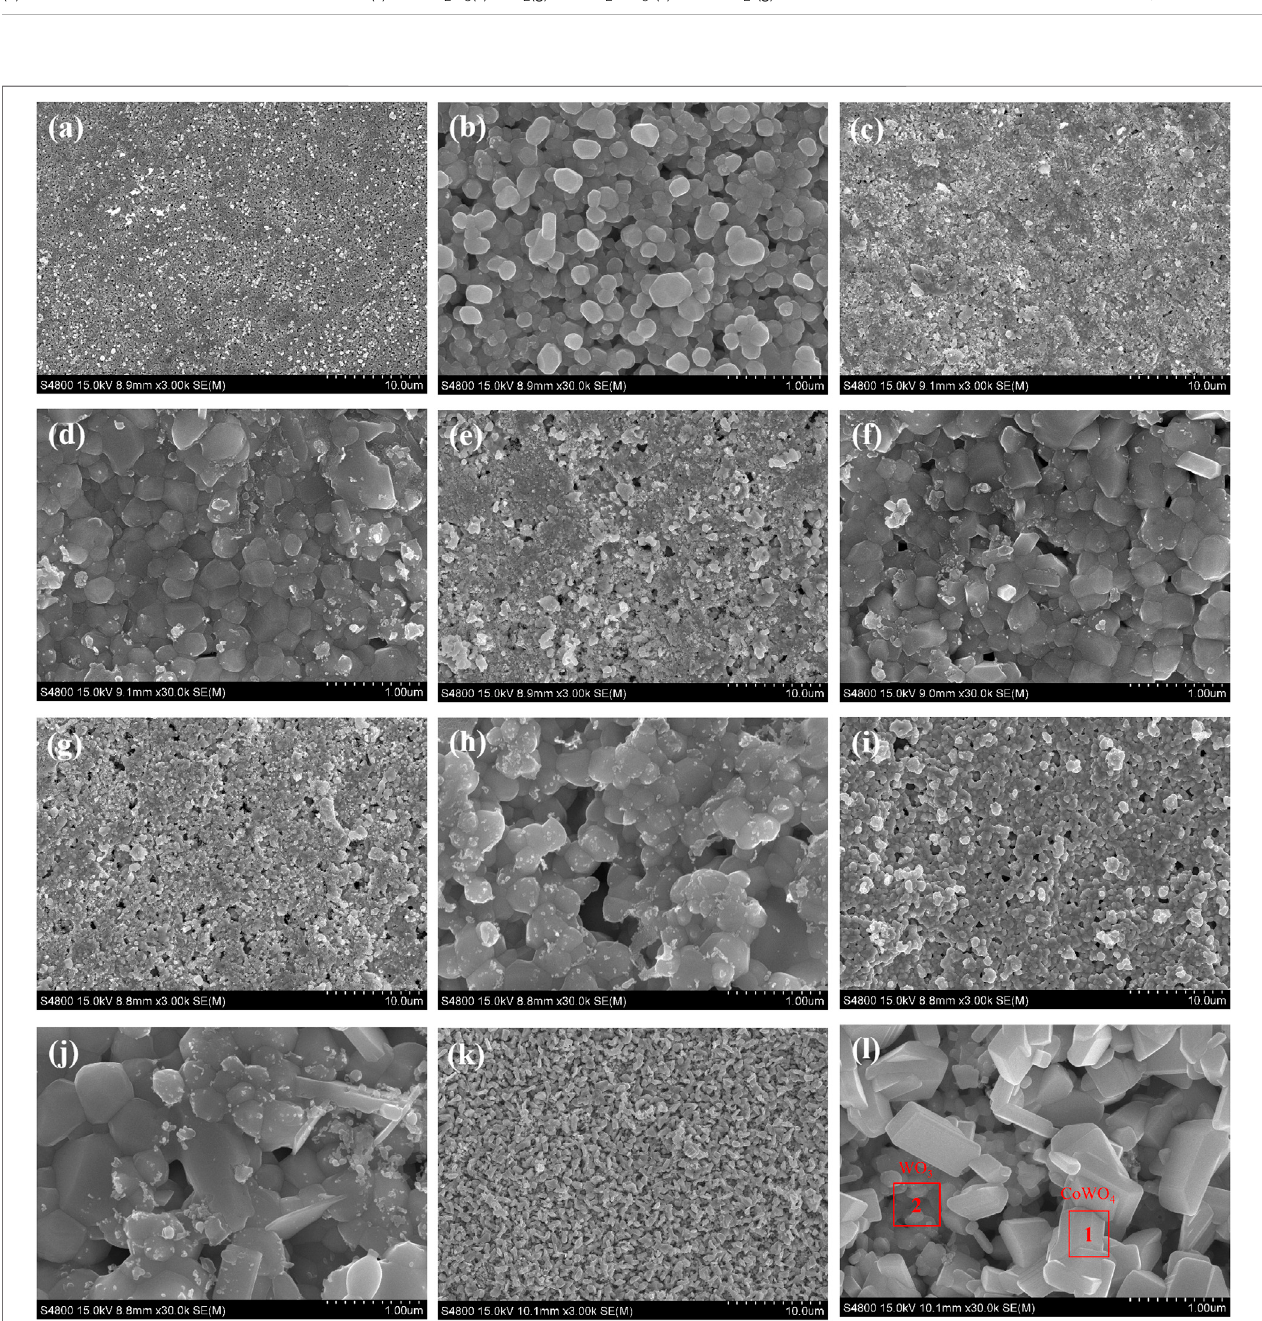
FIGURE3| SurfacemorphologyoftheoxidationlayerofbinderlesstungstencarbidewithdifferentY 2 O 3 contentsandYG3cementedcarbideoxidizedat800 ° Cfor 60 min (A,B) WC; (C,D) WC-1 wt.% Y 2 O 3 ; (E,F) WC-2 wt.% Y 2 O 3 ; (G,H) WC-3 wt.% Y 2 O 3 ; (I,J) WC-4 wt.% Y 2 O 3 (K,L) YG3.